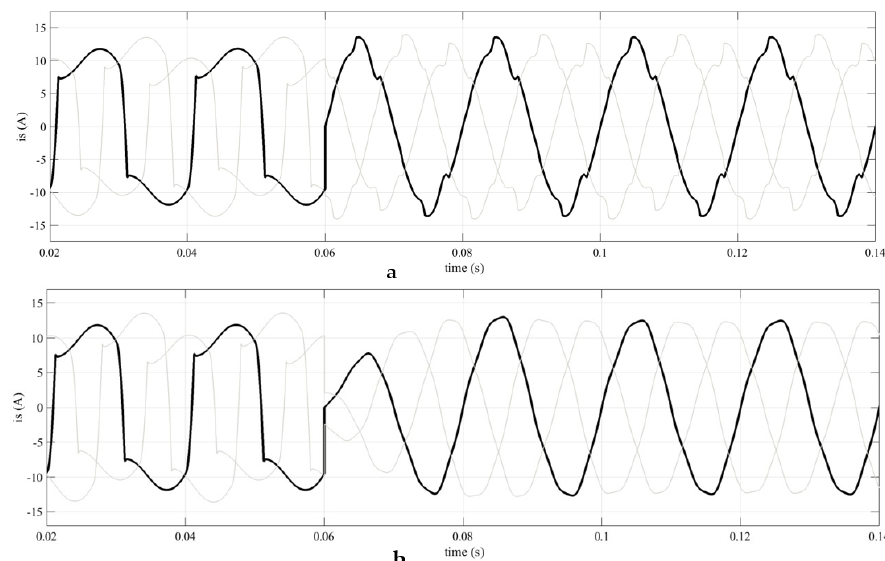
Figure 10. ( a ) Supply currents before/after instantaneous compensation (TIC). ( b ) Supply currents before/after average compensation (TAC); compensation is achieved in a cycle and a half. Compen- sation at t = 0.06 s.